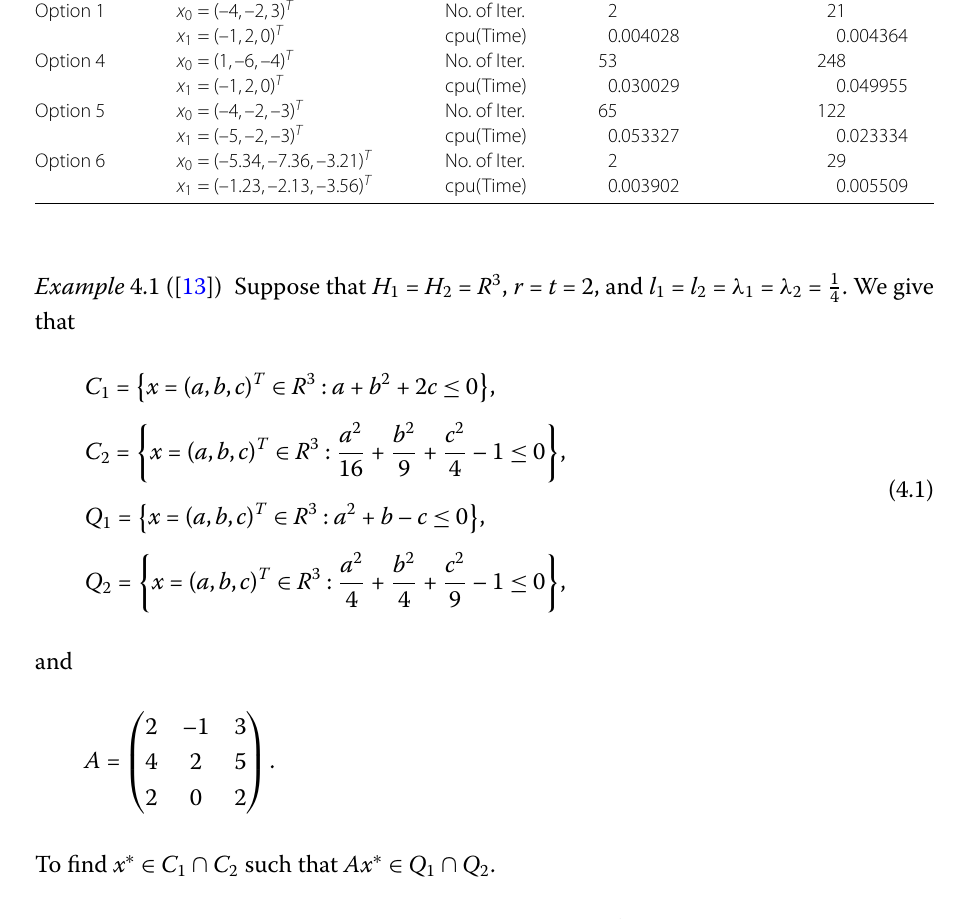
Alg 3.1 in this paper Alg 3.1 in